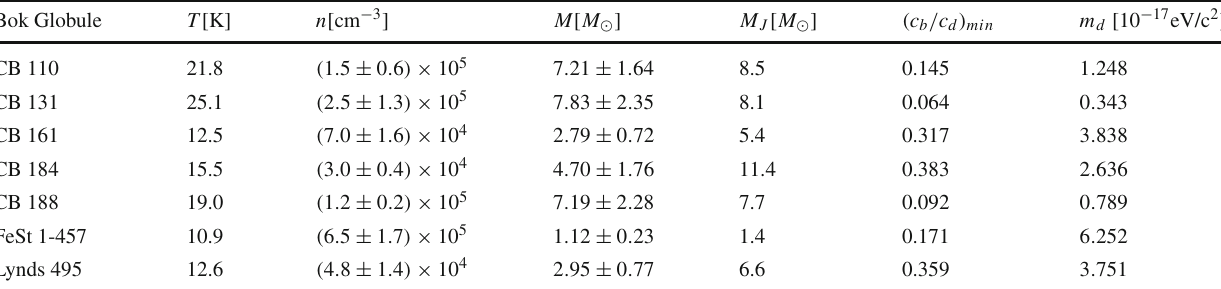
Table 2 Kinetic temperature, particle number density, mass, and Jeans mass for 7 of the Bok globules of Table 1, whose predicted stability is contradicted by observation, together with the saturation bounds for c b / c d obtained with Eq. (26) and for m d obtained with Eq. (27) Bok Globule